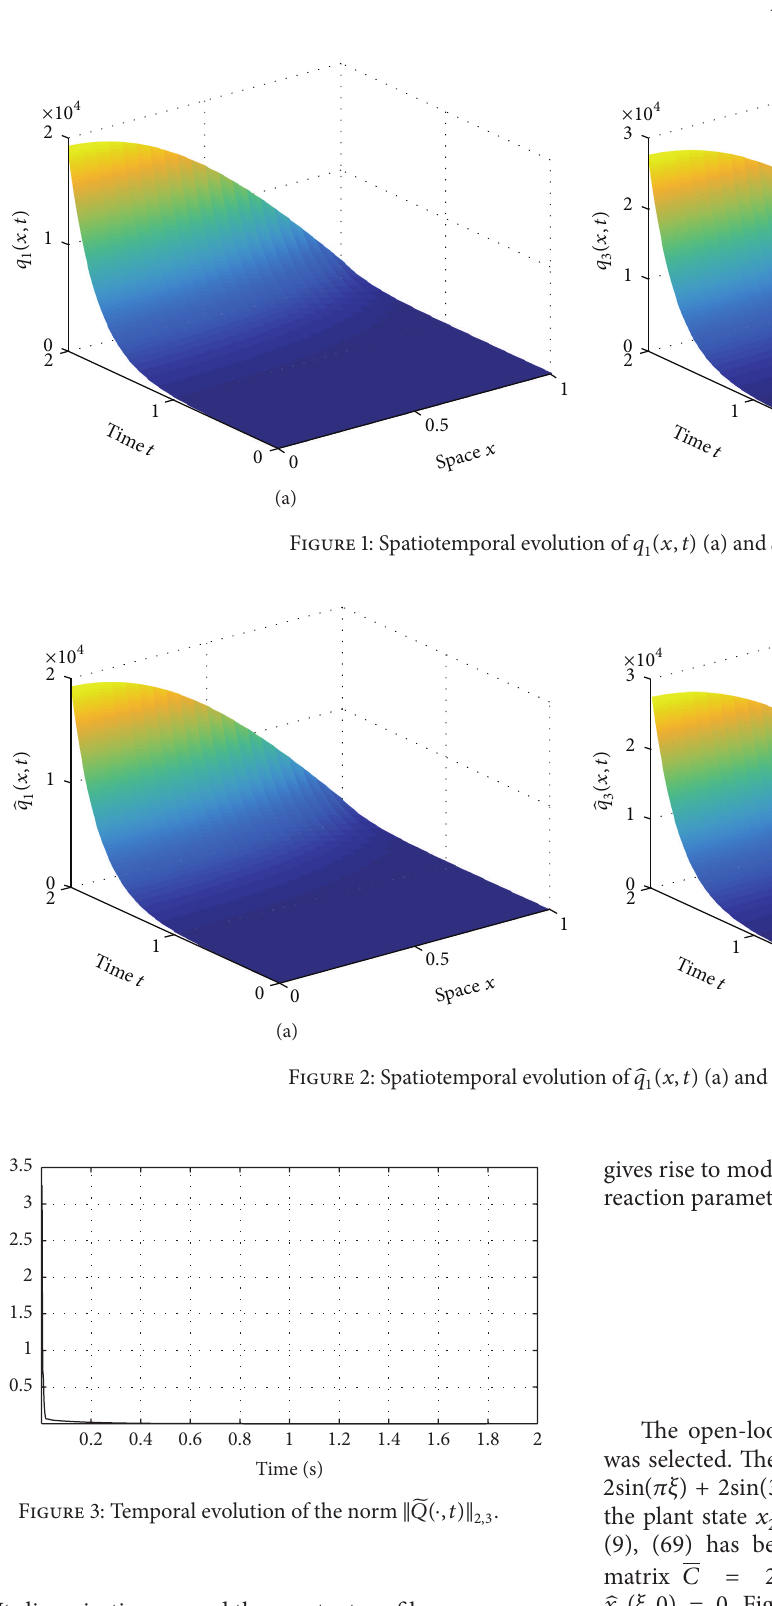
Its linearization around the constant